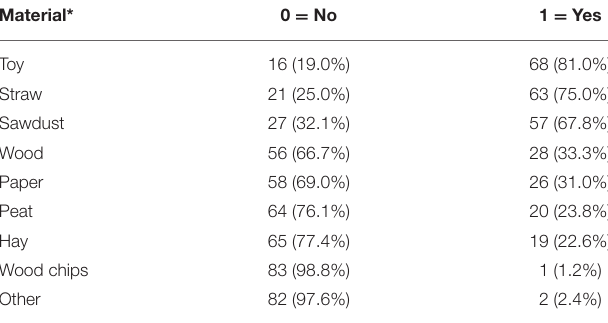
TABLE 4 | Information recorded by veterinarian during one herd health visit on the use of different materials used as environmental enrichment in 84 study herds growing finishing